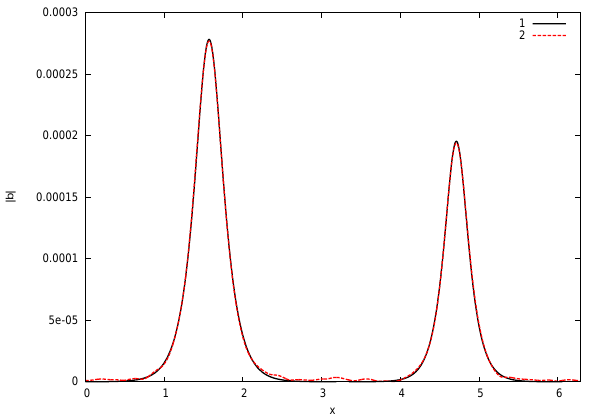
b k after 100 collisions. | |